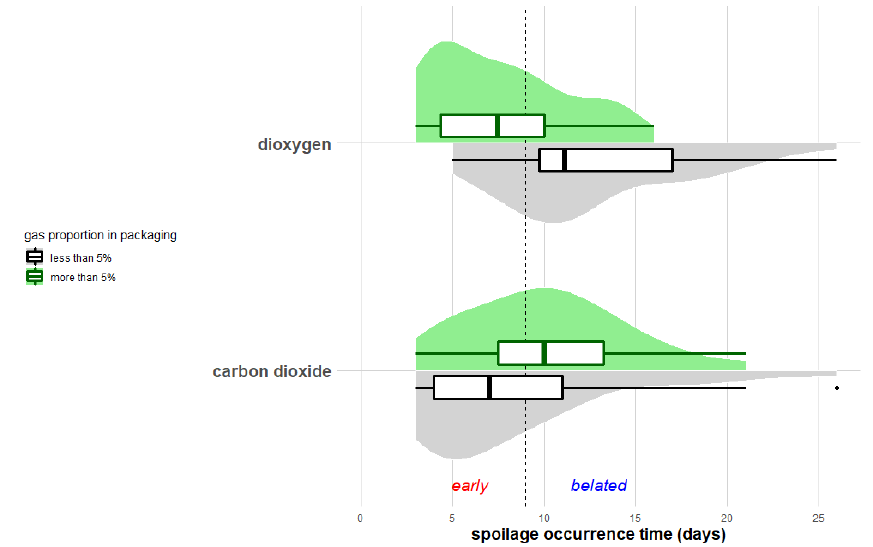
Figure 6. Spoilage occurrence time of meat products stored in packaging containing more or less than 5% of O 2 or carbon dioxide. The vertical dotted line corresponds to the median spoilage time characterizing early and belated spoilage stages.